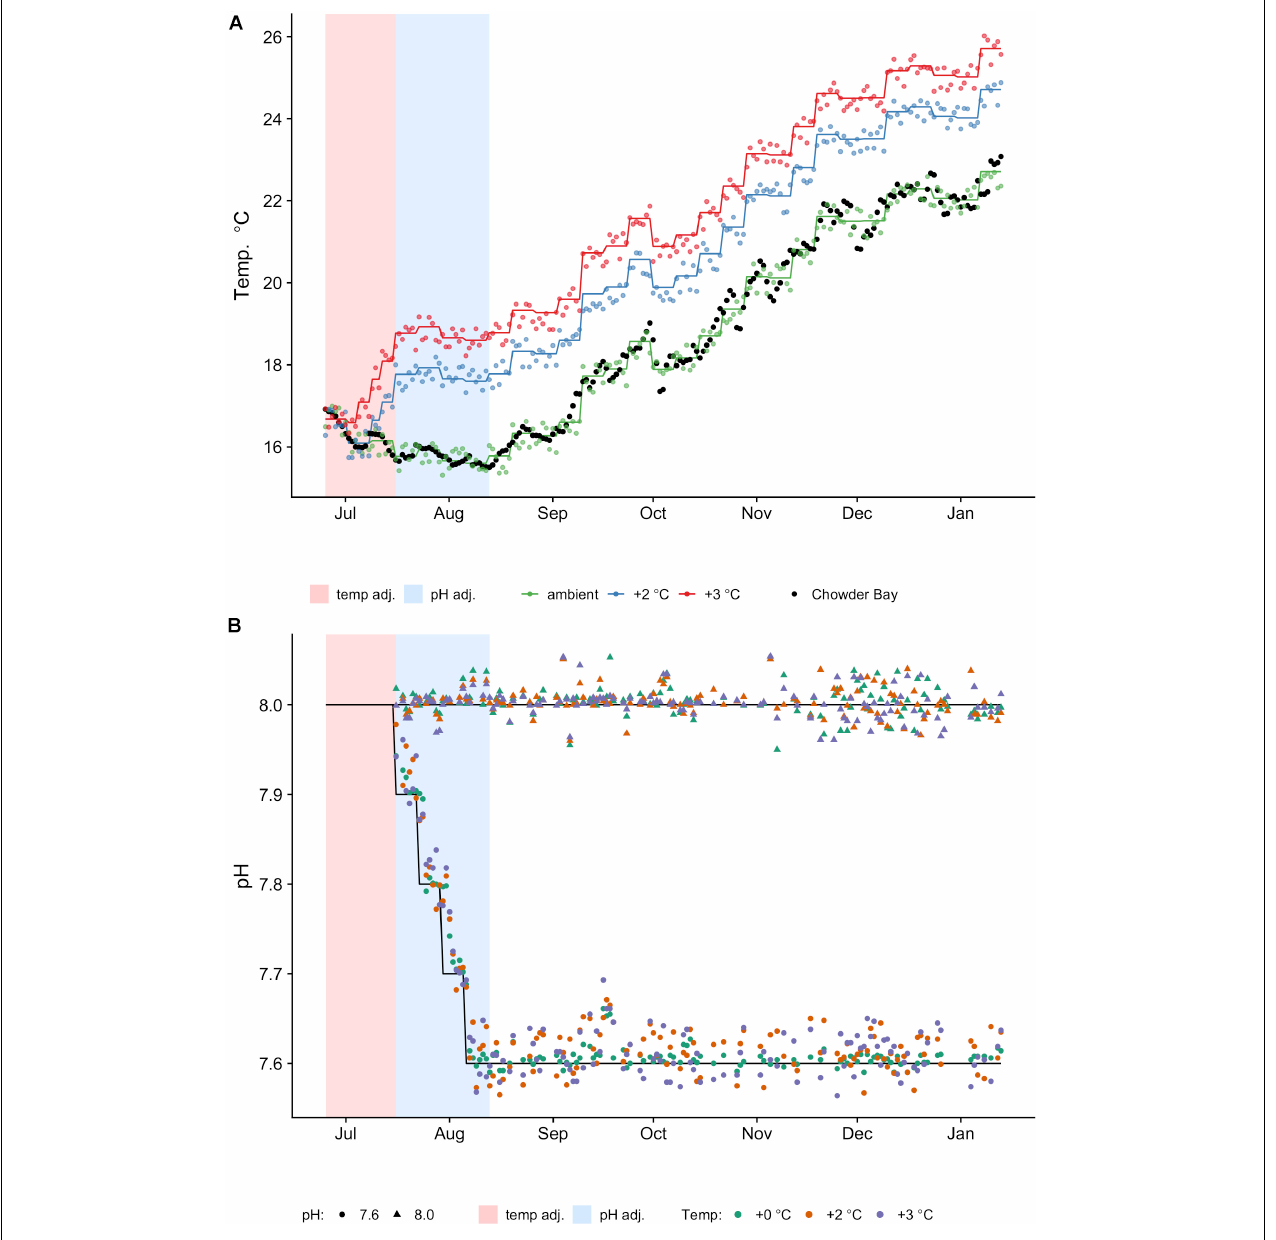
FIGURE 1 | Temperature (A) and pH (B) profiles and measurements taken daily. One replicate tank for every treatment was selected at random for measurements. Shaded regions are the pre-acclimation adjustment periods for temperature (pink) and pH (blue), respectively. (A) Colored lines represent the planned temperature profiles (ambient, +2 ◦ C, +3 ◦ C), which change every week and the dots represent actual temperatures measured (see also Supplementary Table 1 ). Black dots are the reference temperatures collected from in situ loggers deployed in Chowder Bay from 2009 to 2014, averaged by day (see Supplementary Figure 1 ). (B) Black lines represent the reference profiles of constant pH T levels (8.0, 7.6) and initial adjustments. Actual measurements are indicated by shapes (triangle: 8.0; circle: 7.6). The actual mean measured pH values were pH T 8.0 (SD = 0.02, n = 378) and pH T 7.64 (SD = 0.09, n = 384). Colors represent the temperature group (see